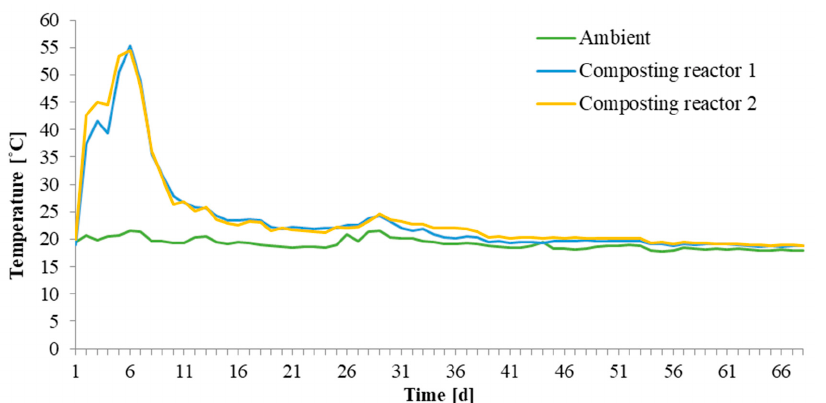
Figure 6. Evolution of temperature during the 16 week laboratory composting (data presented for 9 weeks).